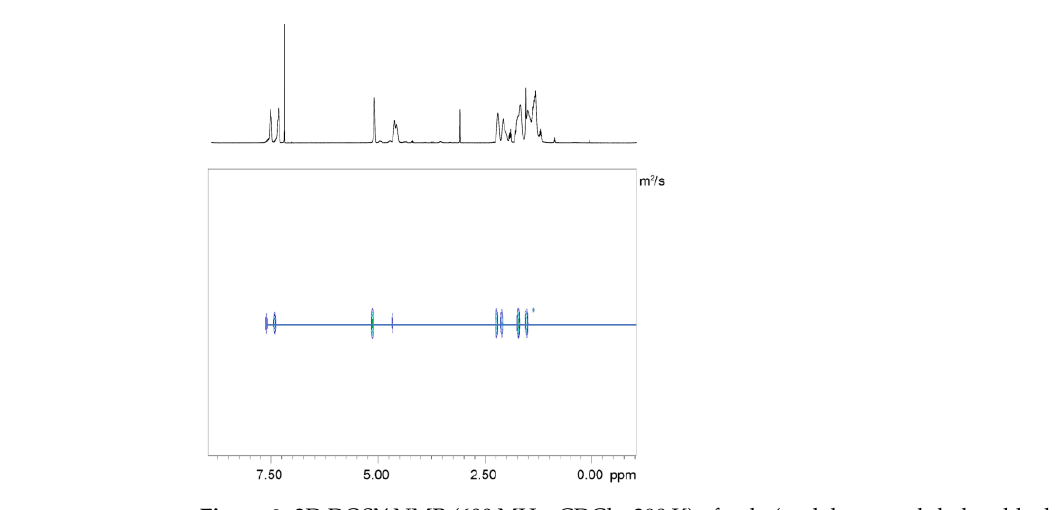
Figure 3. 1 H NMR spectrum (400 MHz, CDCl 3 and 298 K) of poly(cyclohexene phthalate-block-cy- clohexene carbonate) obtained from a mixture of PA, CHO, and CO 2 (entry 2 in Table 3).